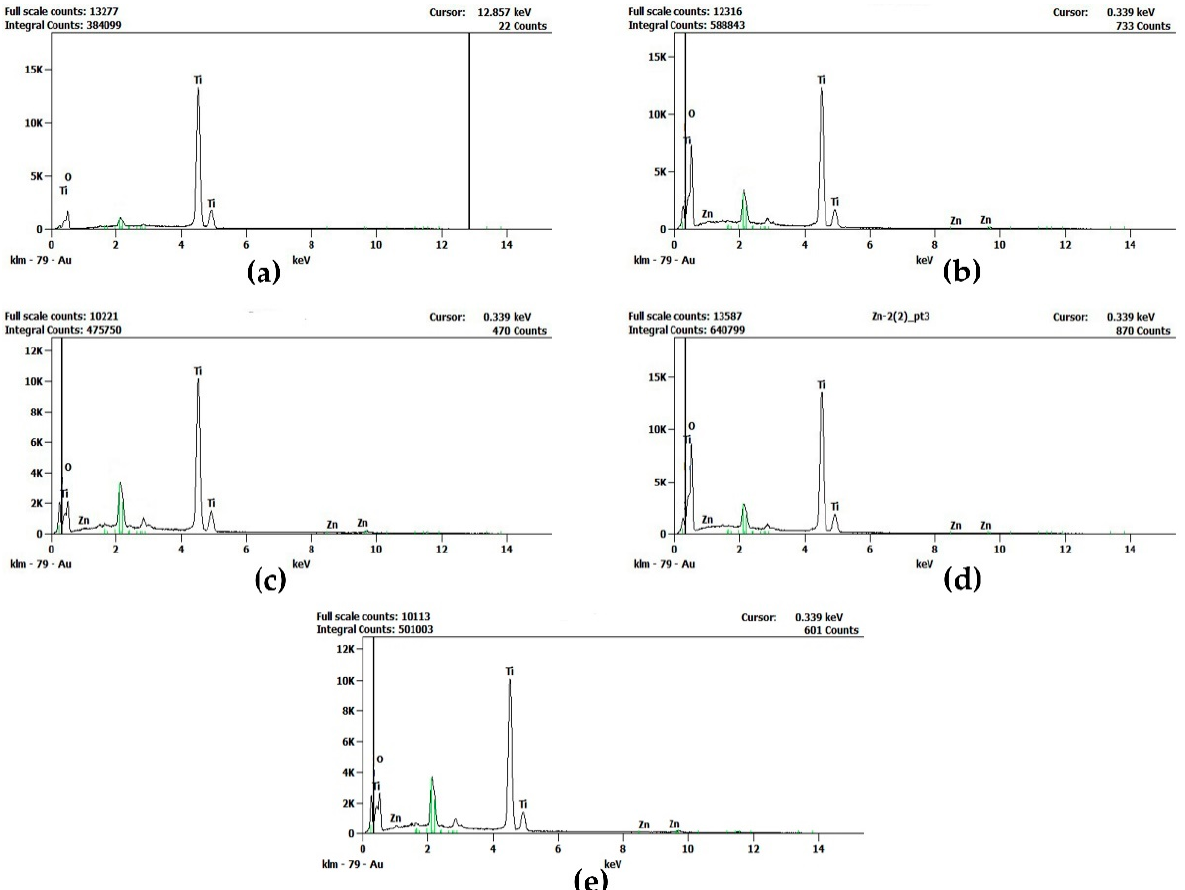
Figure 2. Energy Dispersive X-ray (EDX) spectroscopic images of ( a ) undoped, ( b ) 0.5 mol% Zn-doped, ( c ) 1.0 mol% Zn-doped, ( d ) 1.5 mol % Zn-doped, and ( e ) 2.0 mol% Zn-doped TiO 2 nanomaterials. Table 1. Mole percentage of Zn in Zn-doped TiO 2 nanomaterials.